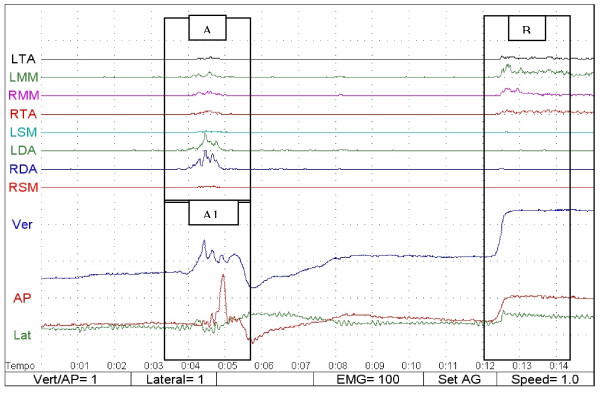
Polygraphy of swallowing: A = rectified SEMG during swallowing; A1 = kinesiography during swallowing, B = polygraphy in occlusal position; LTA (left anterior temporalis); RTA (right anterior temporalis); LMM (left masseter); RMM (right masseter); LSM (left sternocleidomastoid); RSM (right sternocleidomastoid); LDA (left submentalis); RDA (right submentalis). Ver (blue line): vertical component of mandibular movement; AP (red line): anteroposterior component of mandibular movement; Lat (green line): lateral component of mandibular movement.